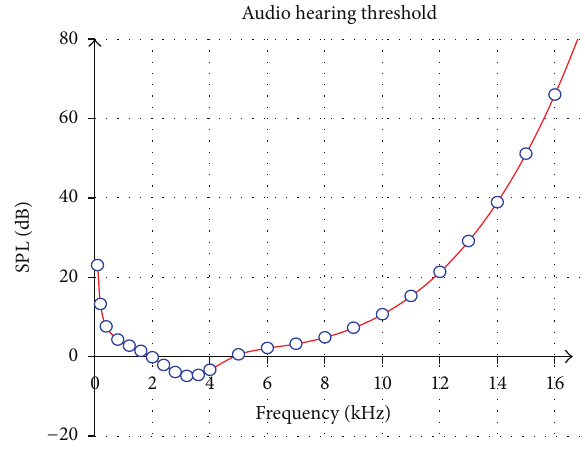
Figure 1: The absolute threshold of hearing under quiet